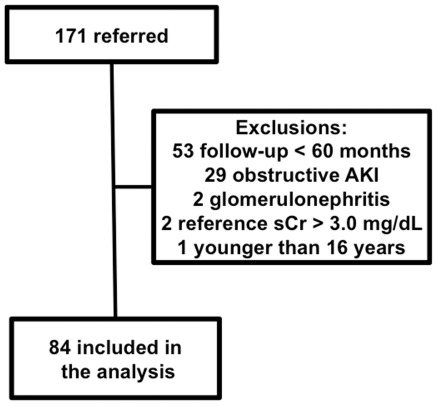
Flowchart of patients included in the analysis.AKI: acute kidney injury; sCr: serum creatinine.